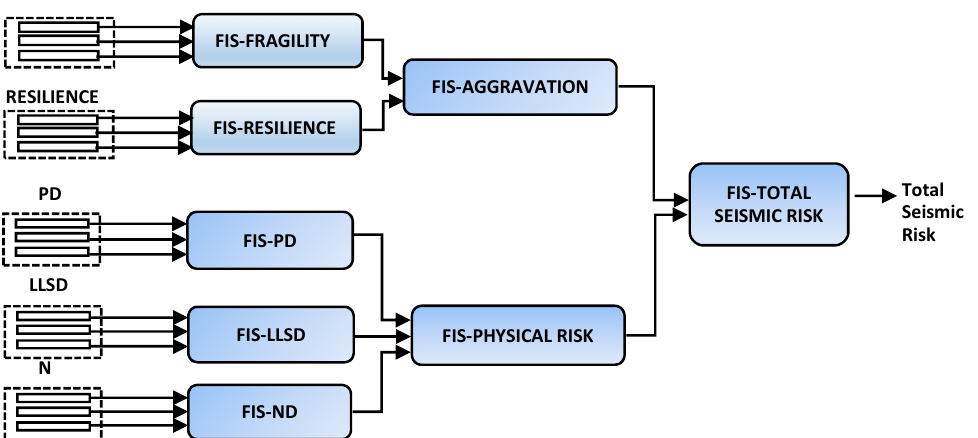
Figure 1. Conceptualization of the Seismic Risk Fuzzy Model. White rectangles represent indicators either describing social economic fragility or physical risk. Here: PD = Property Damage, LLSD = Life Line Sources Damage, ND = Network Damage, FIS = Fuzzy Inference System.